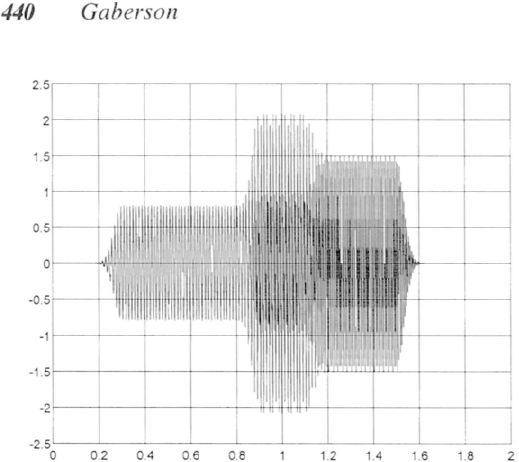
FIGURE 1 Time history of Twosines test signal. with a 256-point FFT and 144 time slices, skipping 12 points (or 12 ms) between each time slice. ote